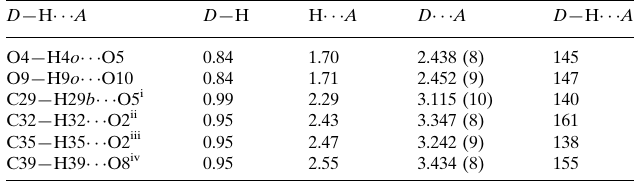
Hydrogen-bond geometry (A˚ , (cid:2)